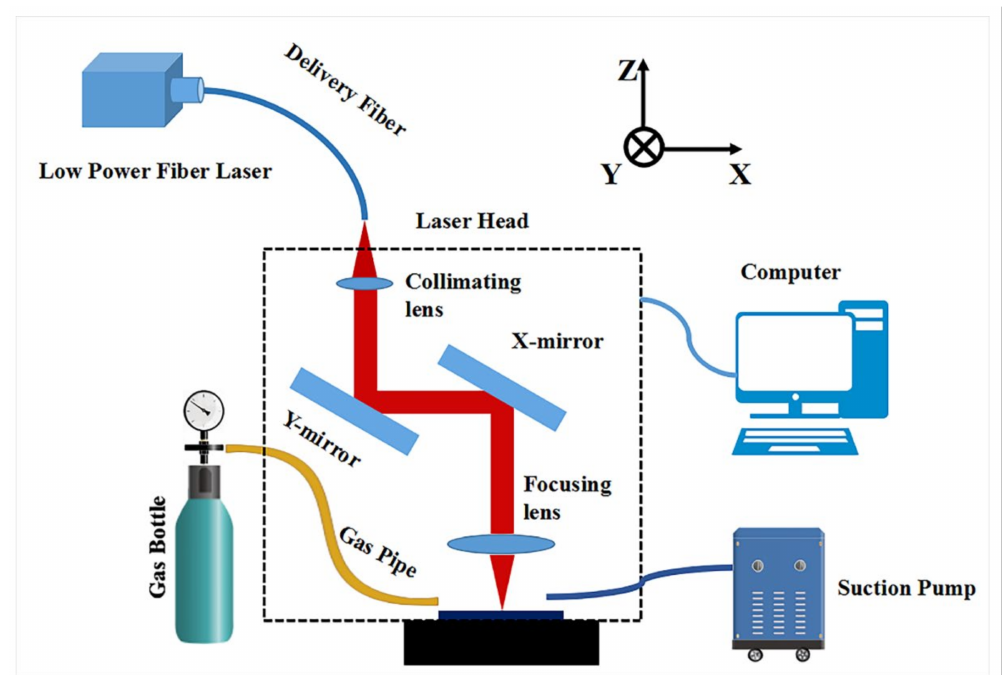
Figure 2. Schematic of setup for laser paint removal.